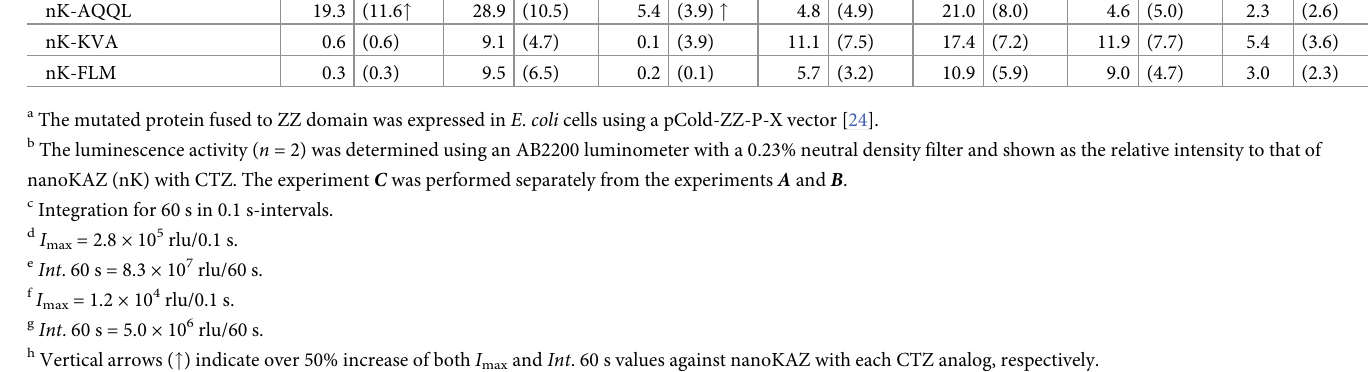
a The mutated protein fused to ZZ domain was expressed in E . coli cells using a pCold-ZZ-P-X vector [24]. b The luminescence activity ( n = 2) was determined using an AB2200 luminometer with a 0.23% neutral density filter and shown as the relative intensity to that of nanoKAZ (nK) with CTZ. The experiment C was performed separately from the experiments A and B . c Integration for 60 s in 0.1 s-intervals.